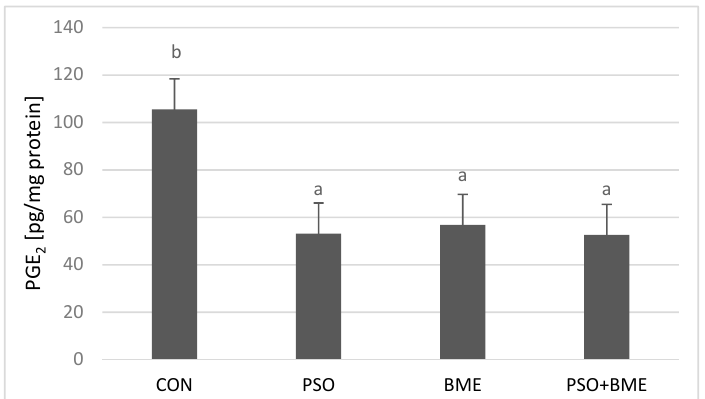
Figure 7. PGE 2 (pg/mg protein) content in liver of experimental groups. CON—control group; PSO— Figure 7. PGE 2 (pg / mg protein) content in liver of experimental groups. CON—control group; group receiving PSO in the amount of 0.15 mL/day; BME—group receiving BME ad libitum; PSO + PSO—group receiving PSO in the amount of 0.15 mL / day; BME—group receiving BME ad libitum; BME—group receiving PSO in the amount of 0.15 mL/day and BME ad libitum. All data are shown PSO + BME—group receiving PSO in the amount of 0.15 mL / day and BME ad libitum. All data are shown as mean values ± standard deviation of data obtained from all animals ( n = 12) in each group. Values with a di ff erent letter index in one row are significantly di ff erent from each other ( p ≤ 0.05) in post-hoc RIR Tukey